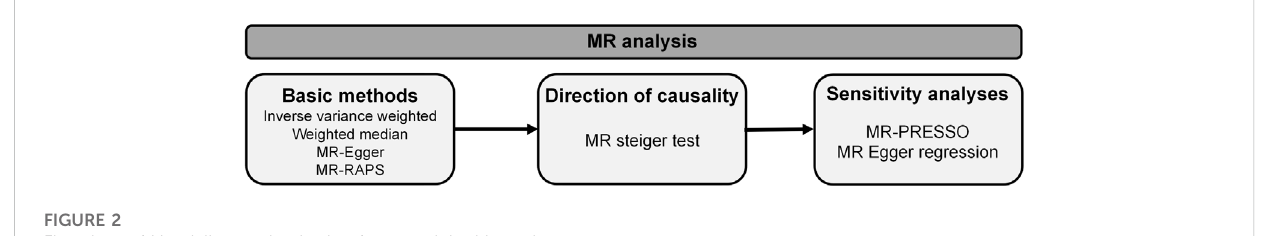
FIGURE 2 Flowchart of Mendelian randomization framework in this